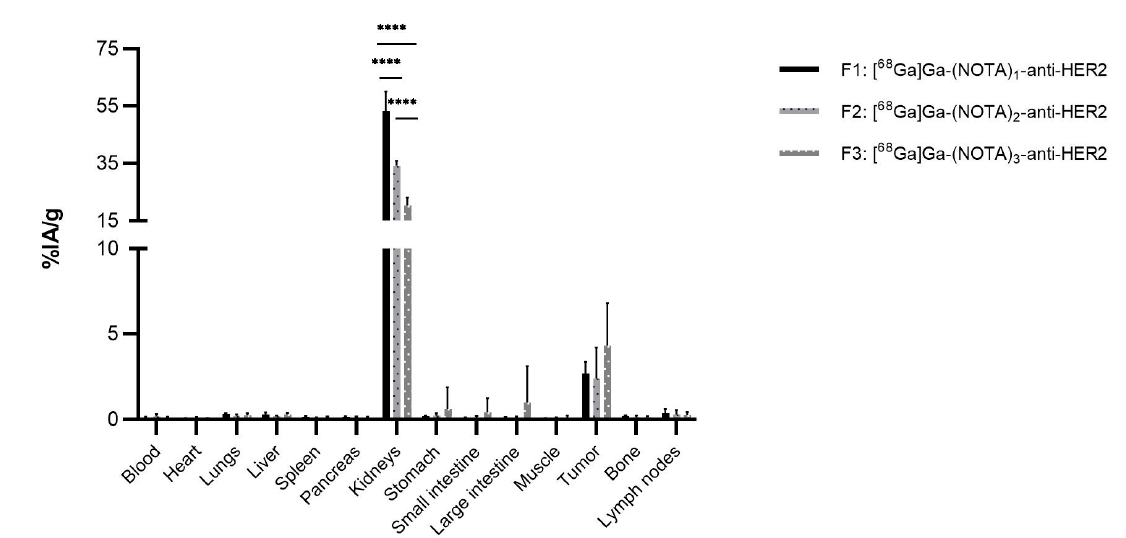
Figure 3. Ex vivo biodistribution analysis of [ 68 Ga]Ga-(NOTA) n -anti-HER2 fractions in athymic nude mice ( n = 6 per group), with a human HER2 expressing SKOV-3 tumor. (**** p < 0.001).